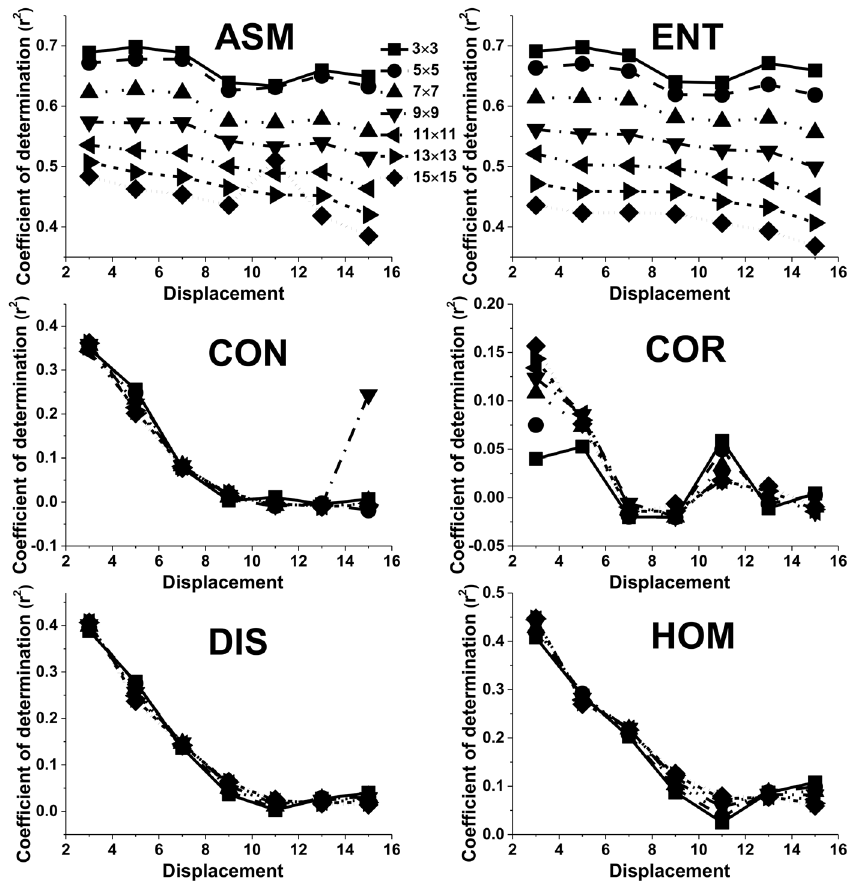
Figure 4. The effect of the displacement parameter on the values of adjusted r 2 for different texture features when the orientation was set to 45° and the window size was set to 3 × 3, 5 × 5, 7 × 7, 9 × 9, 11 × 11, 13 × 13, and 15 × 15